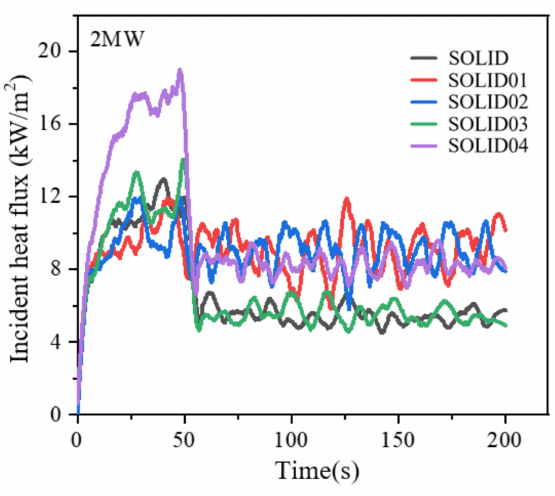
Figure 17. Glass incident heat flux variation under window sprinkler